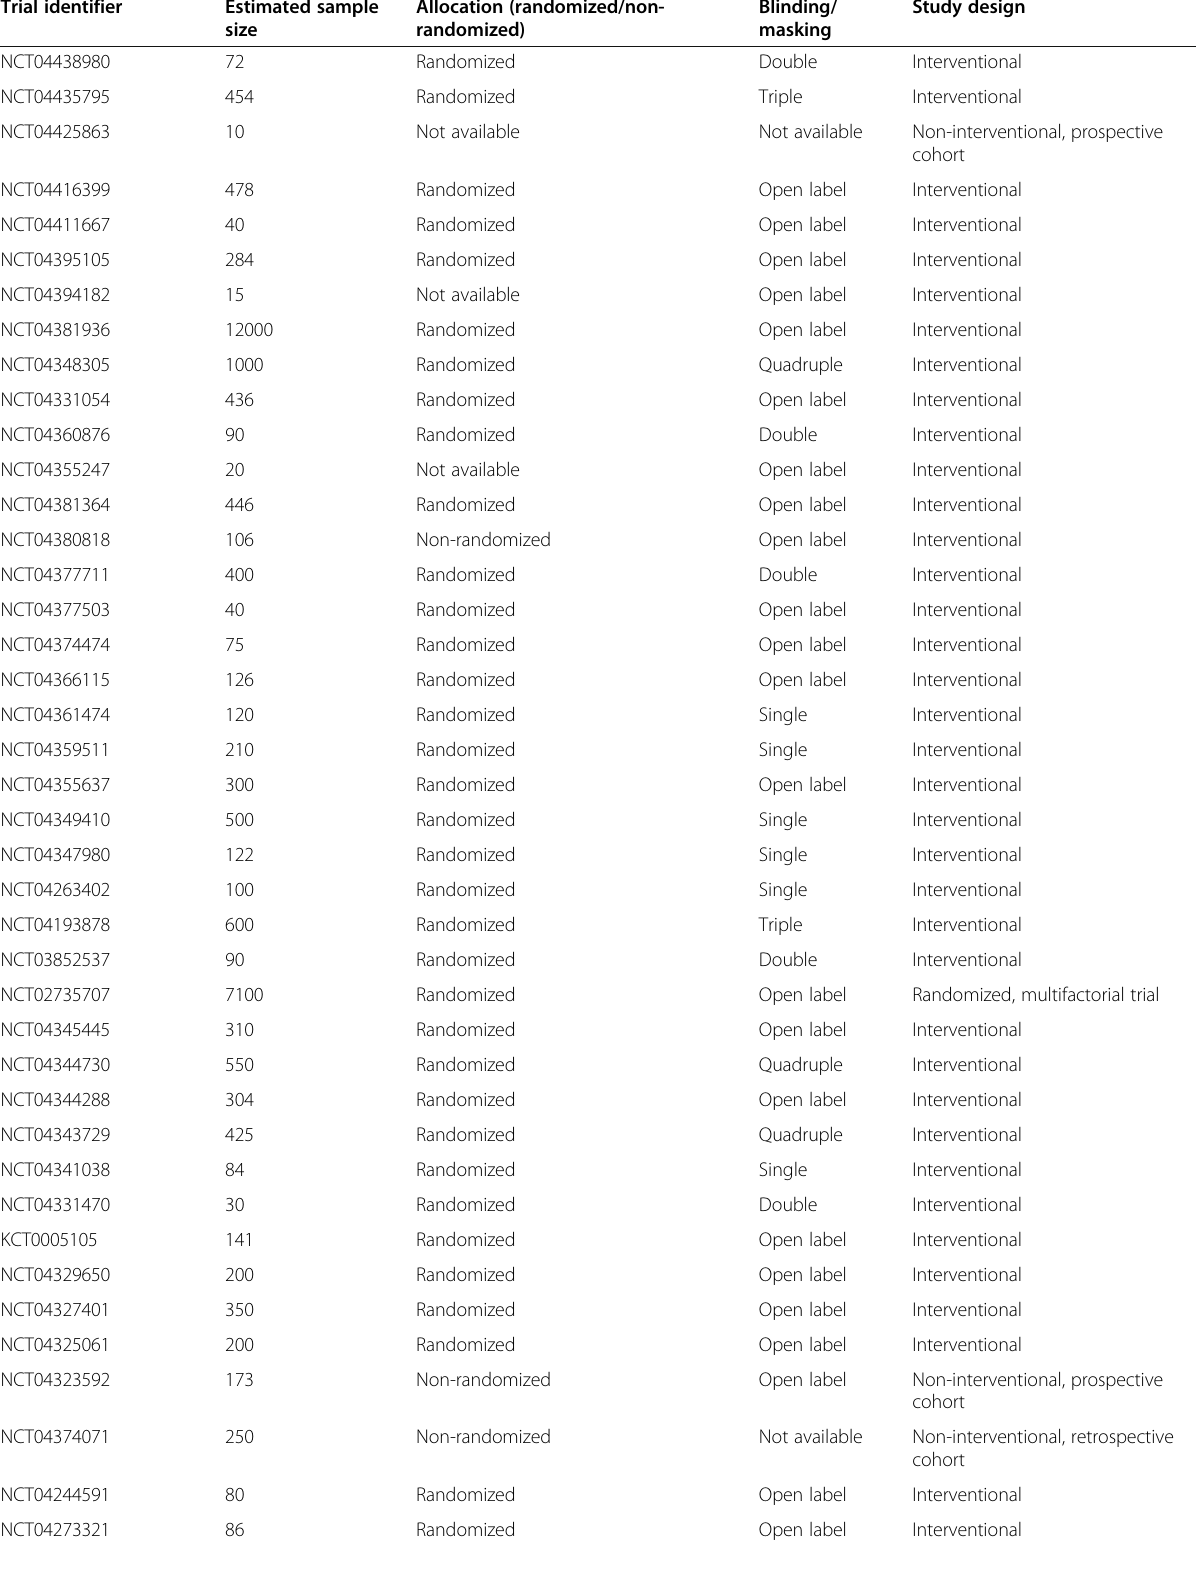
Table 2 Methodological quality of included trials Trial